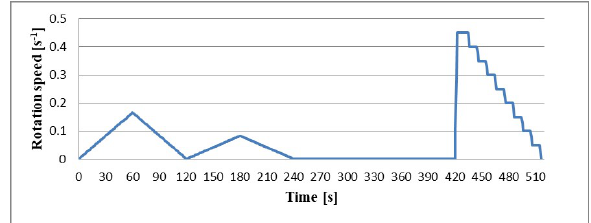
Figure 5: Rheology measuring protocol - the variation of rotation speed with